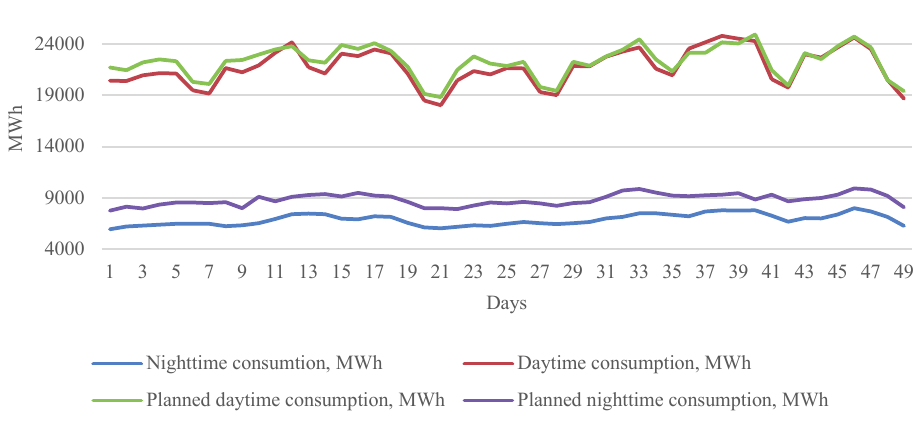
Fig. 4. Electricity planned and real consumption during